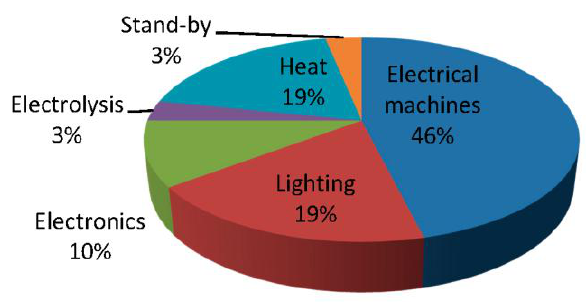
Figure 1. Global electricity demand by sector and end-use.